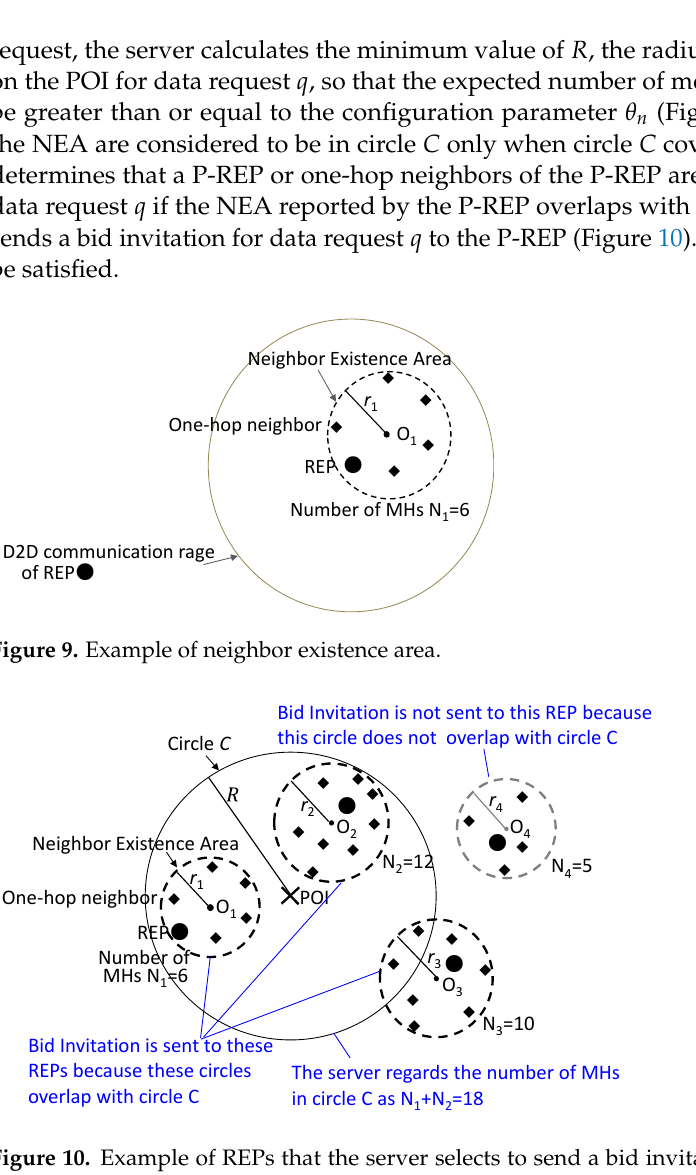
Figure 10. Example of REPs that the server selects to send a bid invitation for a data request (for 𝜃 𝑛 = 17 ).